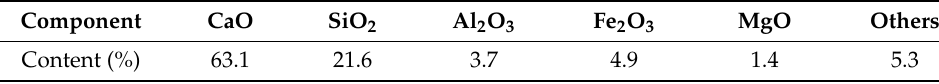
Table 1. Chemical composition of oil well cement.